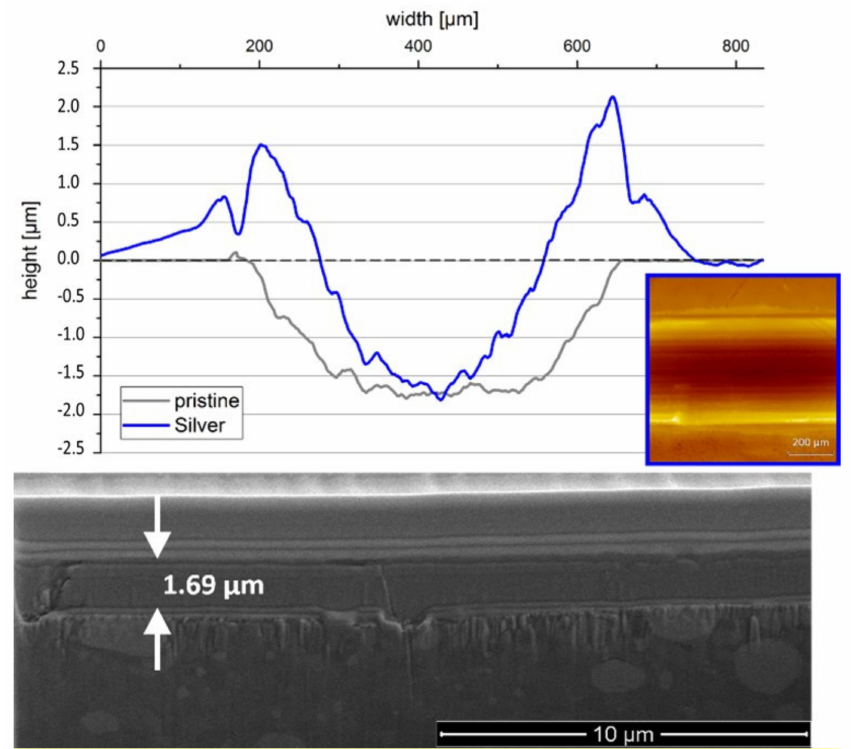
Figure 5. ( Top ) Cross-sectional profile of the wear track on a silver-containing surface (10 µ m, blue) in comparison with a reference (grey). The inset shows the corresponding wear track. ( Bottom ) Cross-section of the surface inside the wear track analyzed using a focused ion beam (FIB) cut and scanning electron microscopy. The arrows mark the remaining MoN